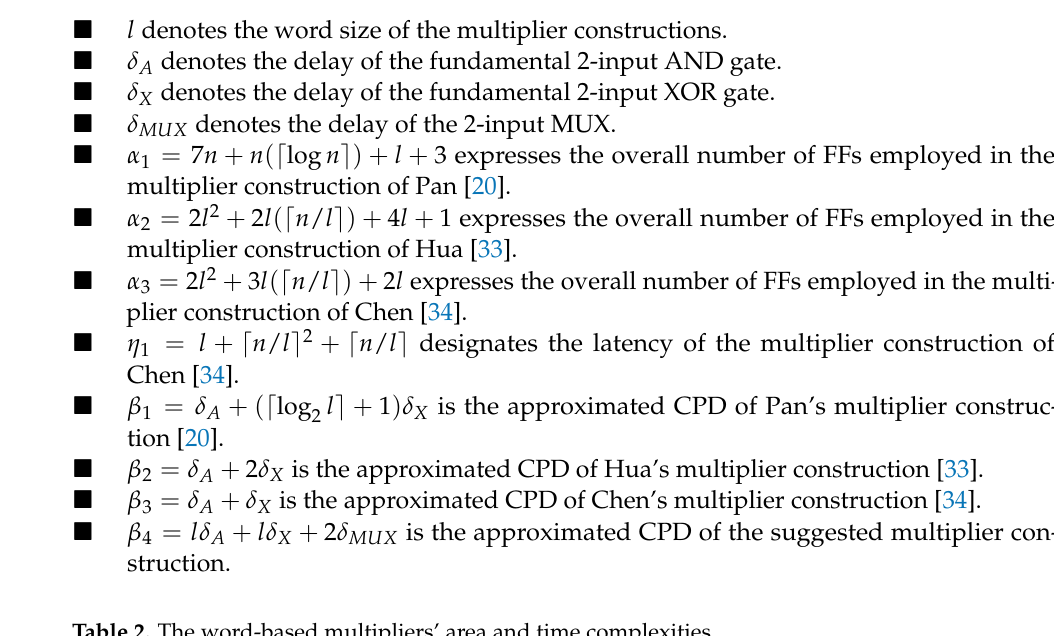
Table 2. The word-based multipliers’ area and time